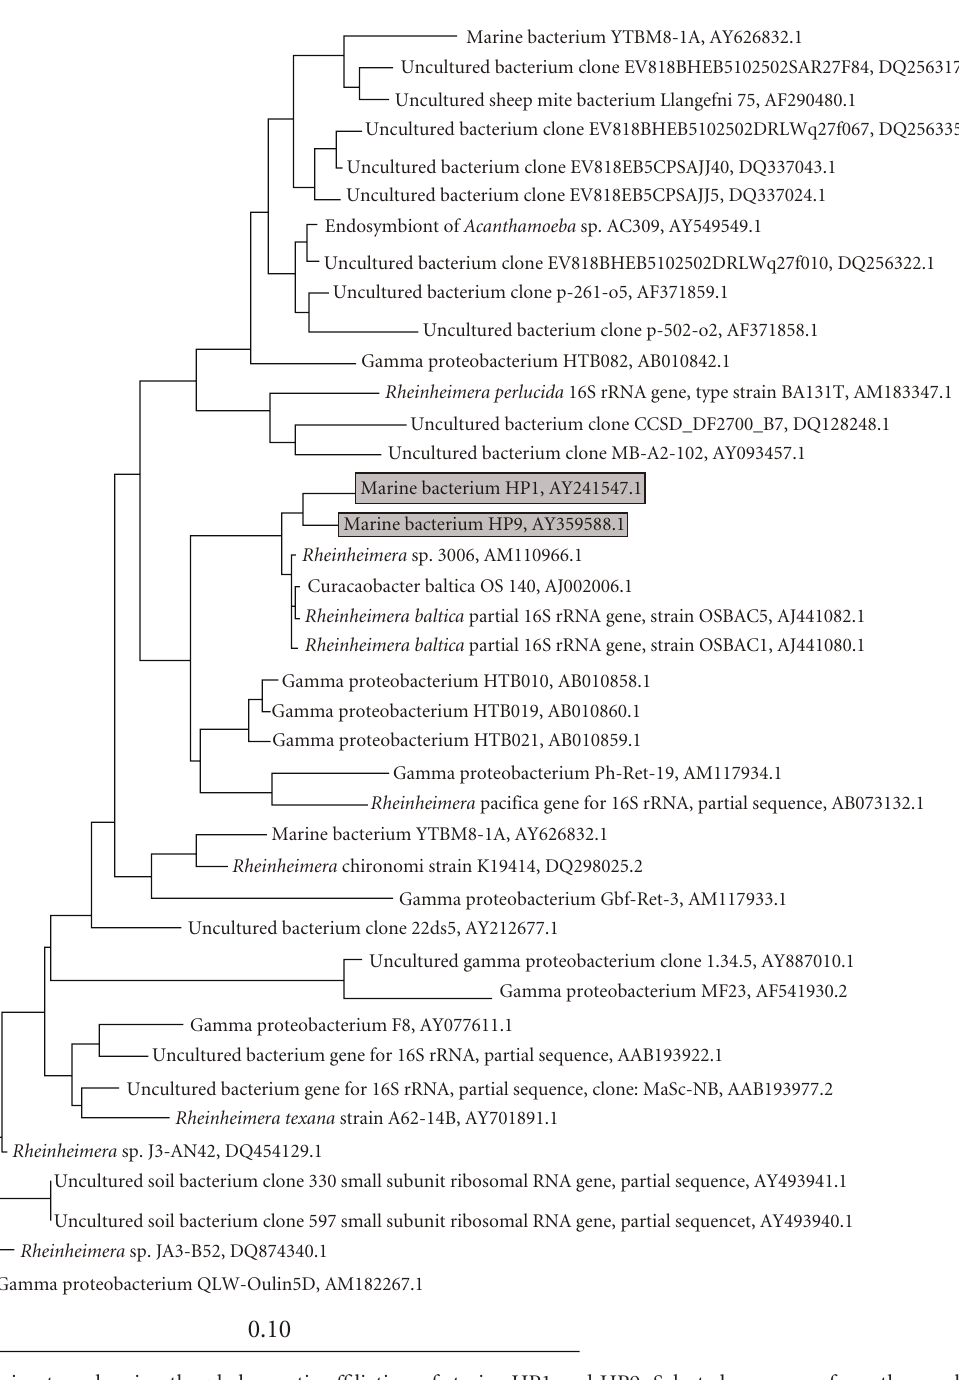
pigment. Due to its blue color and marine origin we named this compound glaukothalin ( glaukos , gr. = blue, thalatta , gr. = sea, Figure 2(a)). Glaukothalin is readily soluble in pyridine or HMPT, moderately soluble in DMSO, DMF or CHCl 3 , and insoluble in acetone, methanol, water